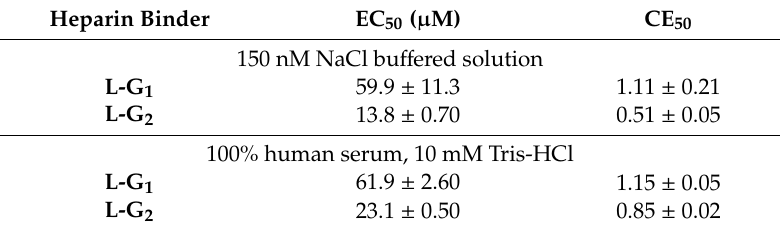
Table 3. Heparin binding data for the self-assembled dendrimers L-G 1 and L-G 2 in 150 mM NaCl bu ff ered solution (10 mM Tris-HCl, pH = 7.4) and in 100% human serum as obtained from the MB displacement assay. Adapted from [26], with the permission of The Royal Society of